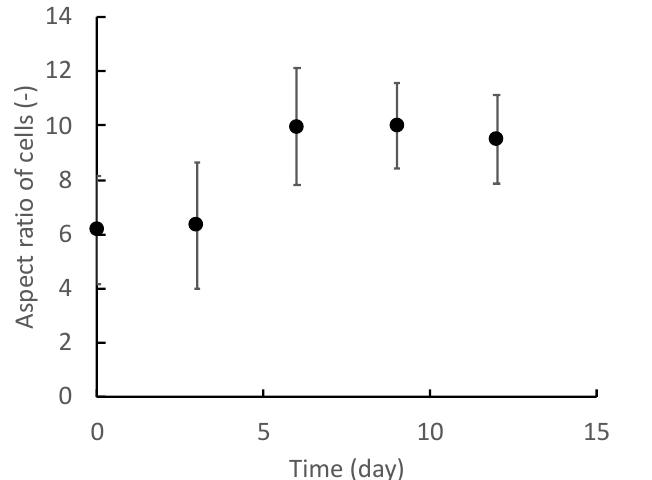
Figure 5. Change in major axis of C2C12 cells during myogenic differentiation culture. Mean +/ − SD, n = 25.